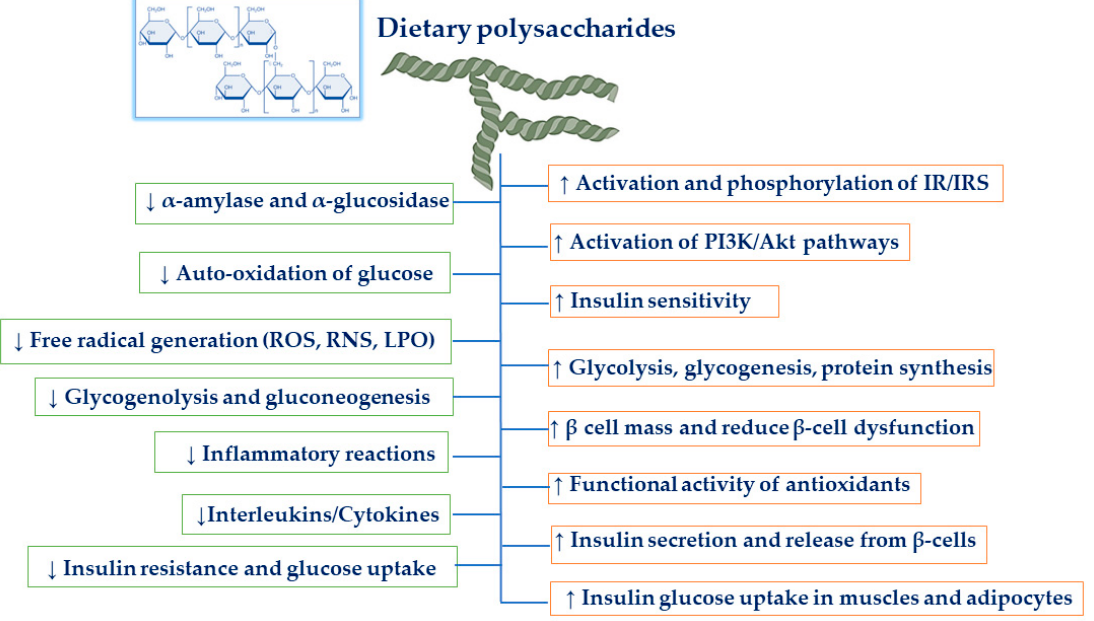
Figure 1. Dietary polysaccharides exert favorable effects on glucose homeostasis and reduce insulin resistance. IR: insulin receptor, IRS: insulin receptor substrate, PI3K: phosphoinositide 3-kinase, AKT: serine/threonine-specific protein kinase, ROS: reactive oxygen species, RNS: reactive nitrogen species, LPO: lipid peroxidation.